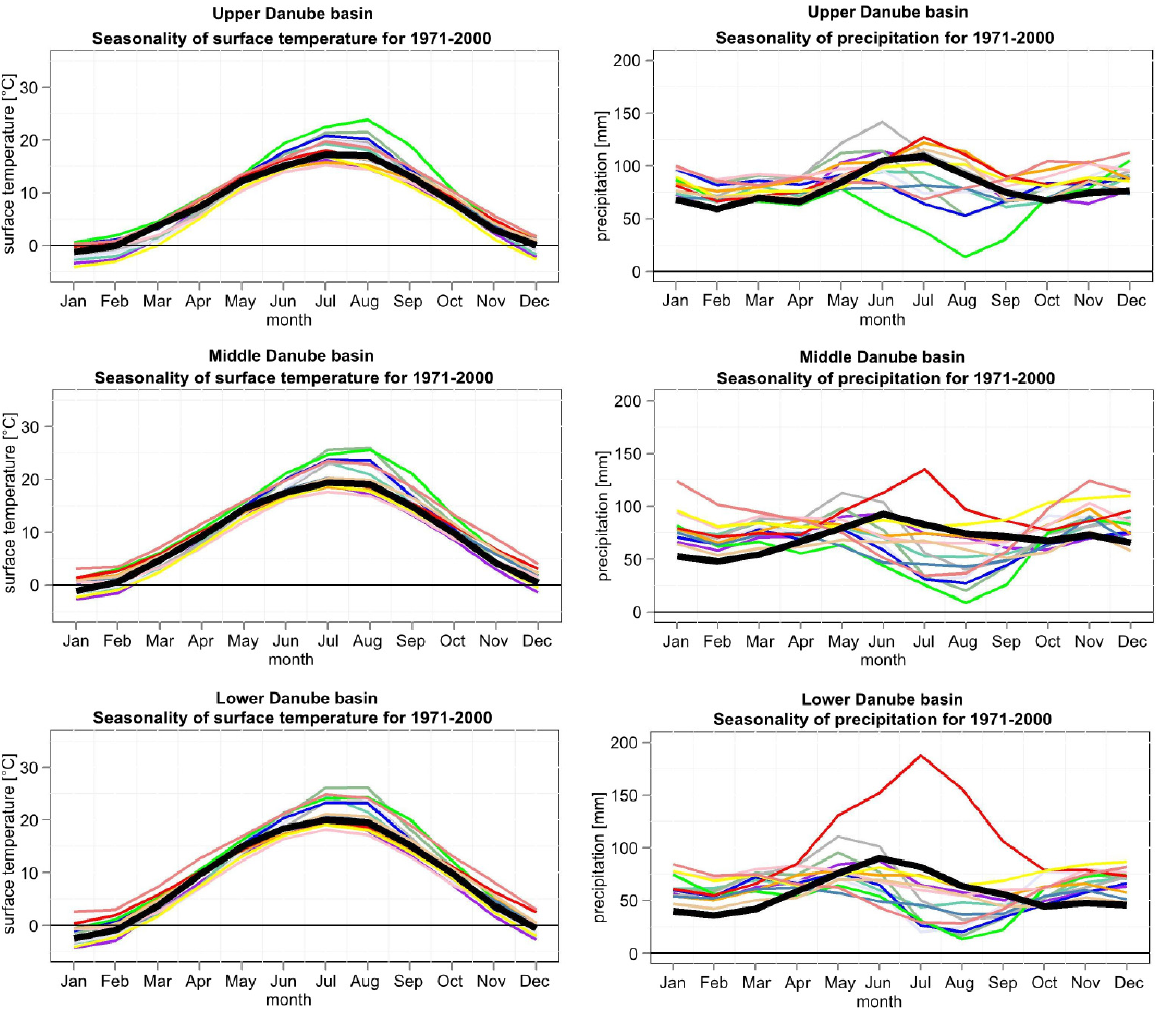
Figure 4. Comparison for the years 1971–2000 of ENSEMBLES [21] regional climate model (RCM) data with historic observations (WATCH data [24]) for the Upper, Middle and Lower Danube basin. The thick black line shows the historic seasonality. The attribution of the different colors to the climate models is shown in Figure B1 (Appendix B).